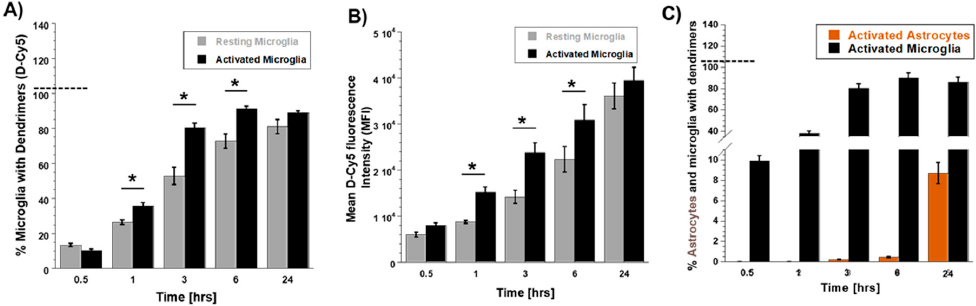
Figure 4. Evaluation of differential dendrimer (D-Cy5) uptake by resting and activated microglial cells in mixed glial culture. ( A ) Flow cytometry analysis of time-dependent differential uptake of dendrimers by resting (non-LPS treated) and activated (LPS treated) microglia/macrophage populations. ( B ) Mean intensity fluorescence (MIF) measurements of FL4 channel showing differential amount of dendrimer uptake or intracellular D-Cy5 in resting and activated microglial cells. ( C ) Delayed and limited dendrimer uptake by astrocyte population (~8.5%) 24 h post dendrimer treatment. All the values are represented as mean ± SEM, n = 4, * p < 0.01, student t -test.